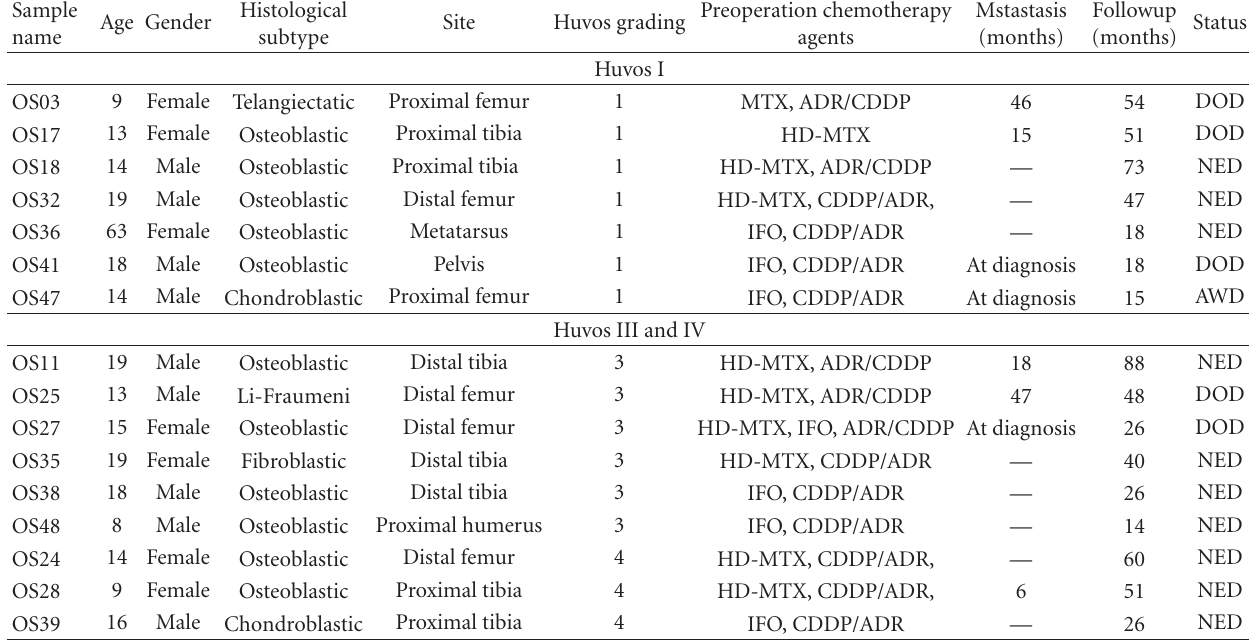
Table 4: Clinicopathological features of osetosarcoma tissue samples for chemosensitivity study. Sample